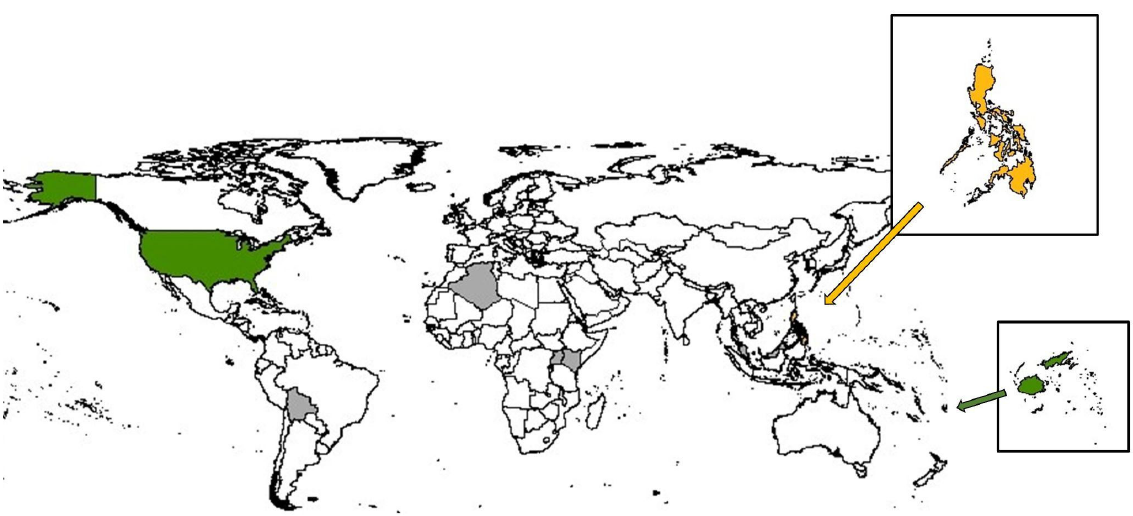
Figure 2. Country representation in current network to catalyze Red List Assessments of underrepresented taxa through academic networks and student engagement. The initial collaboration between partners in the United States and Fiji (green) now includes other partner organizations in Asia, Africa, and South America, which are already actively involved in Red Listing (orange) or are in the early stages of setting up Red Listing projects (grey).